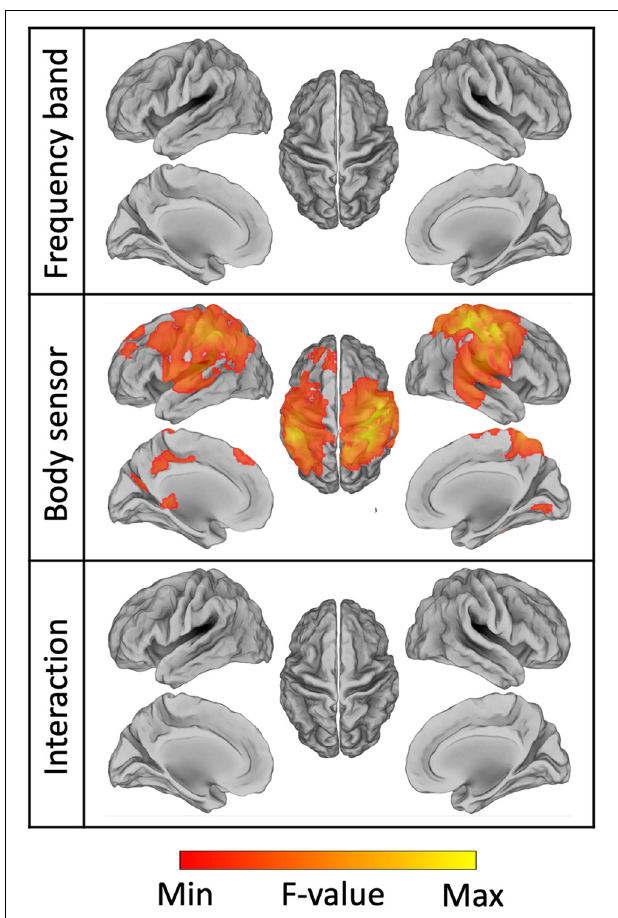
FIGURE 11 | Results of the ANOVA conducted on the source images of brain-body connectivity. We specifically performed a two-way ANOVA, using the frequency band and the body sensors as factors, respectively. The resulting maps for the main effects of frequency band, body sensor, and their interaction are thresholded at p FDR < 0 .